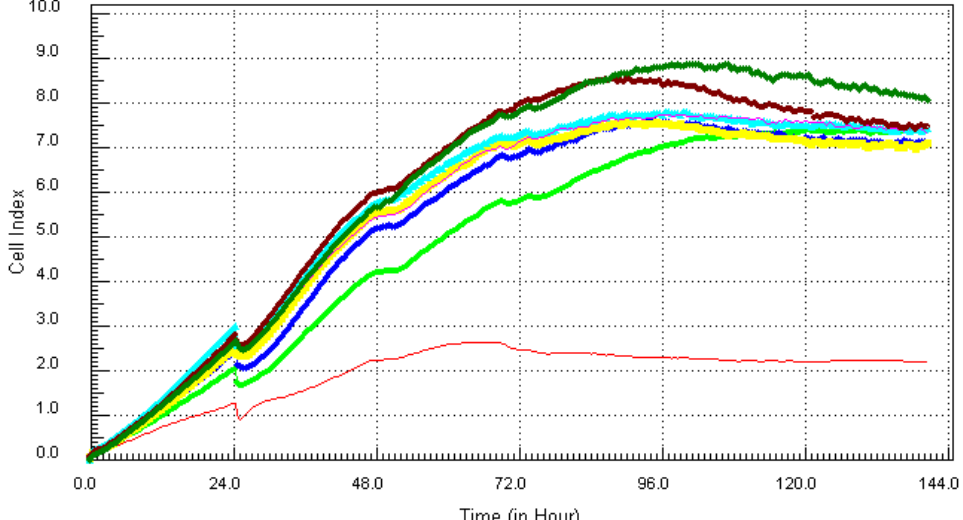
Figure 3. Kinetics of cytotoxic responses for mercury (Hg) in MCF7 cells as described in Figure 1